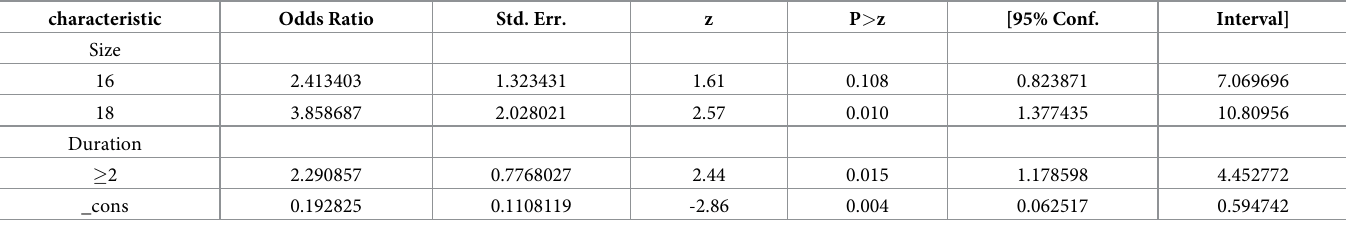
Table 5. Factors significantly associated with bacterial species diversity/ colonisation of the urinary catheter. characteristic Odds Ratio Std. Err. z P > z [95%